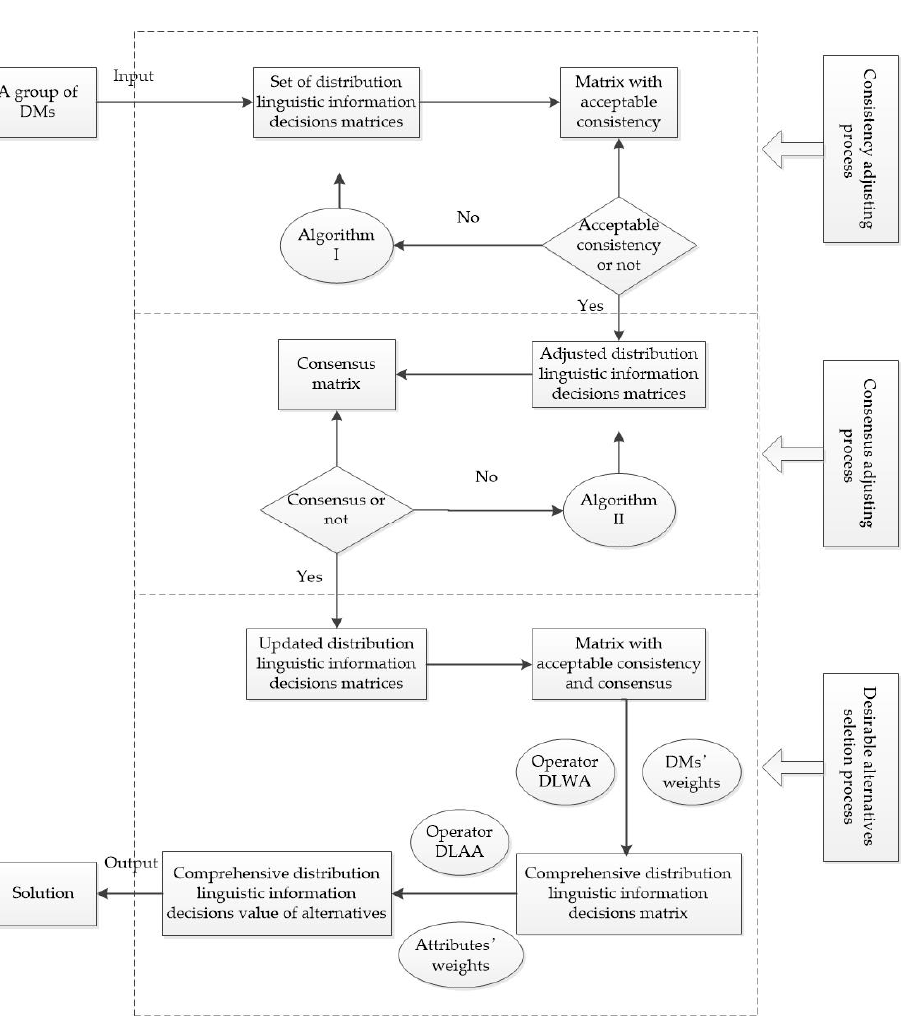
Figure 1. The developed DLFGDM method .